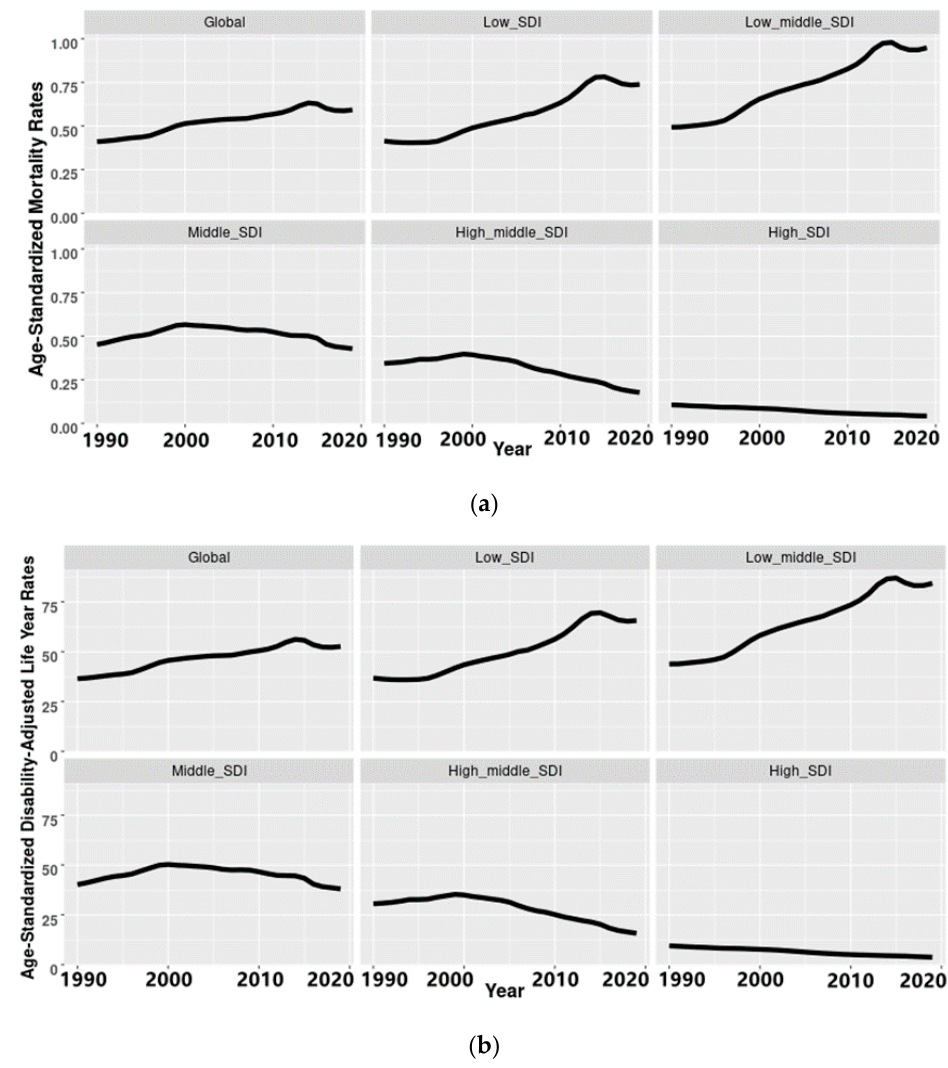
Figure 1. ( a ) The changes of age-standardized mortality rates in PM 2.5 -related preterm birth in the world and different social-demographic index (SDI) regions in 1990–2019. ( b ) The changes of age-standardized disability-adjusted life year rates in PM 2.5 -related preterm birth in the world and different social-demographic index (SDI) regions in 1990–2019.